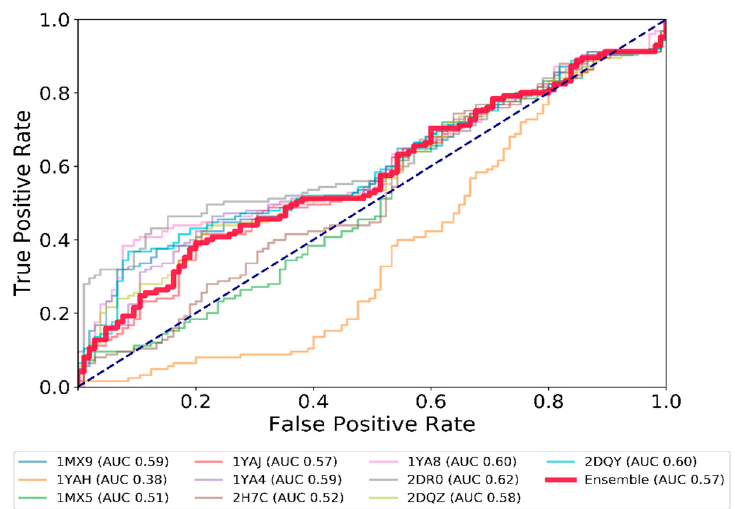
Figure 2. ROC curves showing the performance of docking based on the average energy score for each CES1 ligand docked in the 10 CES1 conformations. Each line corresponds to the results of the correct ranking of active ligands (with an activity below 10 µM) on one X-ray structure of CES1. The red line (Ensemble) considers the average energy score attributed to a ligand across every X-ray structure used in the docking protocol. The dashed line represents a random ranking.